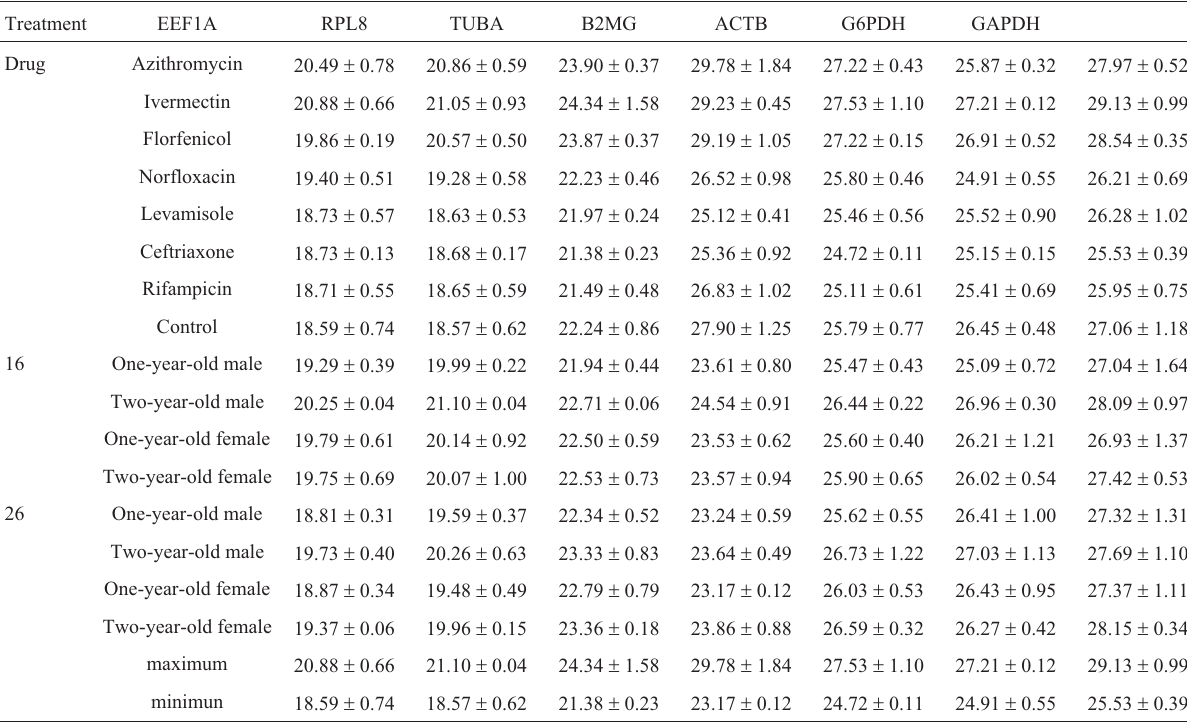
Table 3 - Average Ct values (cid:2) SD of the seven reference genes in the different experimental setups. Treatment EEF1A